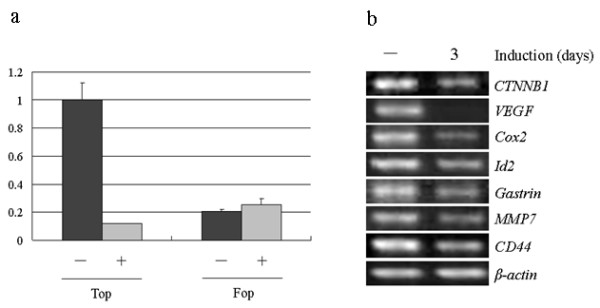
Downregulation of β-catenin/TCF-driven transcription on knockdown of β-catenin. (a) HeLaT-β-catenin-RNAi cells were transfected with TOPFLASH or FOPFLASH luciferase reporter construct. After 3 days with or without DOX treatment, luciferase reporter gene expression was determined. The pRL-TK Renilla luciferase reporter construct was co-transfected in each sample to normalize transfection efficiency. The activity of the reporter luciferase is expressed relative to the activity in control cells, which is defined as 1.0. All experiments were performed in triplicate and are expressed as means and SD. (b) Relative expression levels of known β-catenin/TCF target genes in the HeLaT-β-catenin-RNAi cells following treatment with DOX, as measured by semi-quantitative RT-PCR. β-actin expression is used as a control.